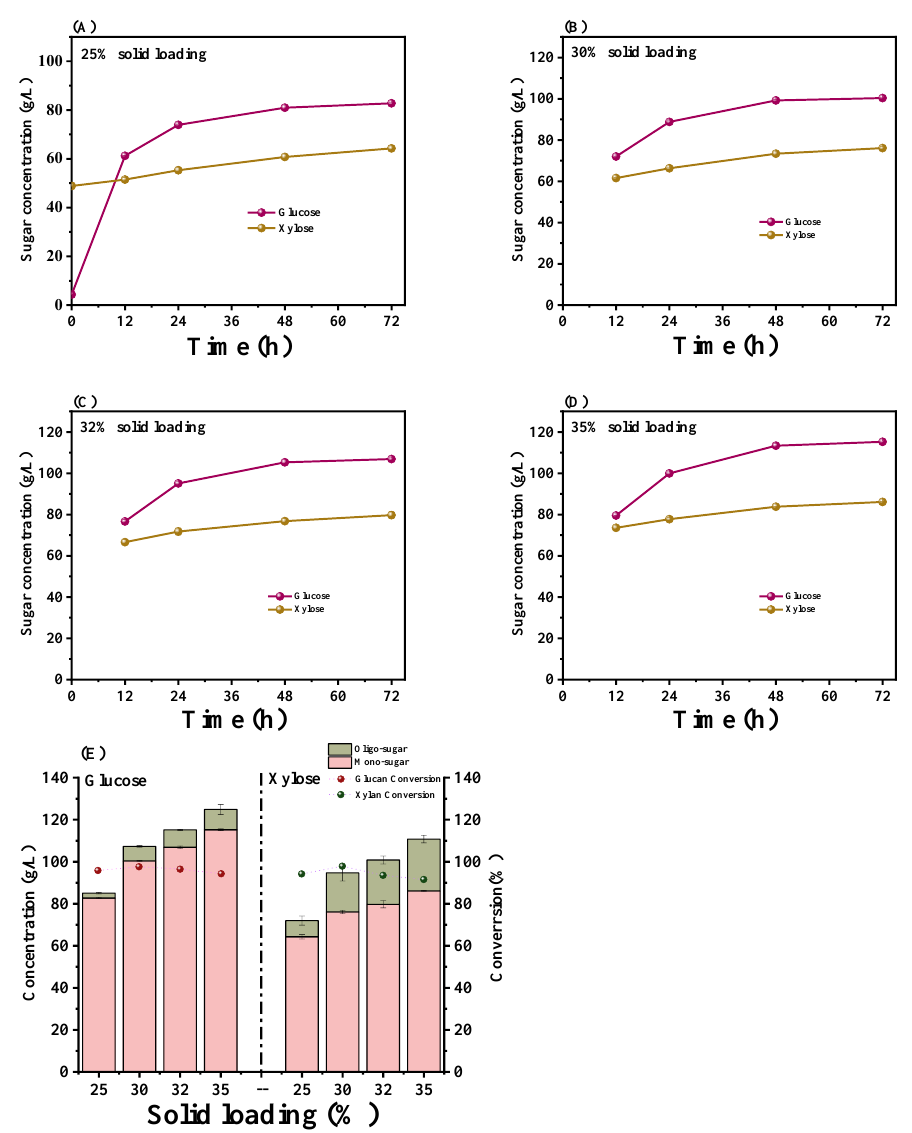
Figure 3. Enzymatic hydrolysis of DLCA(sa)-CC at 25% ( A ), 30% ( B ), 32% ( C ), and 35% ( D ) solid loading and sugar conversions at different solids loadings ( E ). Enzymatic hydrolyses were performed at 50 ◦ C, 250 rpm, and pH 4.8 with an enzyme dosage of 15 mg protein/g glucan. As can be seen from Figure 3E, glucan and xylan conversions were all higher than 90% and reached a maximum of 97.3% and 97.8%, respectively, at 30% solid loading. Sugar conversions decreased slightly as solid loading increased from 30% to 35%. None- theless, the yields for monomeric sugars (glucose and xylose) decreased significantly as more oligomeric sugars generated with increasing solid loading. For instance, the highest glucose and xylose yields were 93.3% and 82.3%, respectively, at 25% solid loading with production of small portion of gluco-oligosaccharides and xylo-oligosaccharides. In con- trast, the glucose and xylose yields decreased to 82.83% and 70.23% when the solid load- ing increased to 35%, with more gluco-oligosaccharides and xylo-oligosaccharides pre- sented in the hydrolysate. Meanwhile, compared to gluco-oligosaccharides, the hydroly- sate contained more xylo-oligosaccharides. It was reported that the large amount of oli- gosaccharides in the hydrolysate affected the activity of CBH through competitive inhibi- tion [26], which is a factor for the slow release of sugars in the late stages of hydrolysis. Another main reason for the decreased glucose and xylose yields is that more pretreat- ment degradation products/inhibitors presented as a higher solid loading, which strongly inhibits cellulases [27]. Meanwhile, the heat and mass transfers were also impaired by high solid loading [28]. As a consequence, the rate of enzymatic conversion decreased, and the oligosaccharide content increased. Furthermore, the feedback inhibition of glu- cose on cellulase [29 – 32] was also stronger at higher glucose concentration, which in- creased with increasing solid loading. In addition, unproductive binding of cellulase to lignin was also an adverse factor affecting enzymatic hydrolysis [33]. 3.4. Separate Hydrolysis and Co-Fermentation for Ethanol Production Fermentation performance is a key criterion for determining whether DLCA(sa)-CC can be used at a large scale for bioethanol production. The aforementioned hydrolysates with different solids loadings were fermented with S. cerevisiae CRD5HS. Hydrolysates at all solids loadings were fermented successfully with ethanol titer increased with increas- ing solid loading (Figure 4). Ethanol titer for 30% solid loading increased by 10.8% com- pared to 25% solid loading, while the ethanol titer increase was only 0.7% when solid loading increased from 32% to 35%. It is also worth noting that the production rate of ethanol was fast in the first 12 h due to the fast utilization of glucose by the strain. The production rate was reduced with increasing solids loadings. For example, at 12 h, the ethanol titer was 41.7 g/L at 25% solid loading as well, as it decreased to 35.1 g/L at 35% solid loading. This may be due to the increase of inhibitors, viscosity, and osmolality in the higher solids loadings, which resulted in the greater inhibition to the yeast and slower sugar utilization [34].